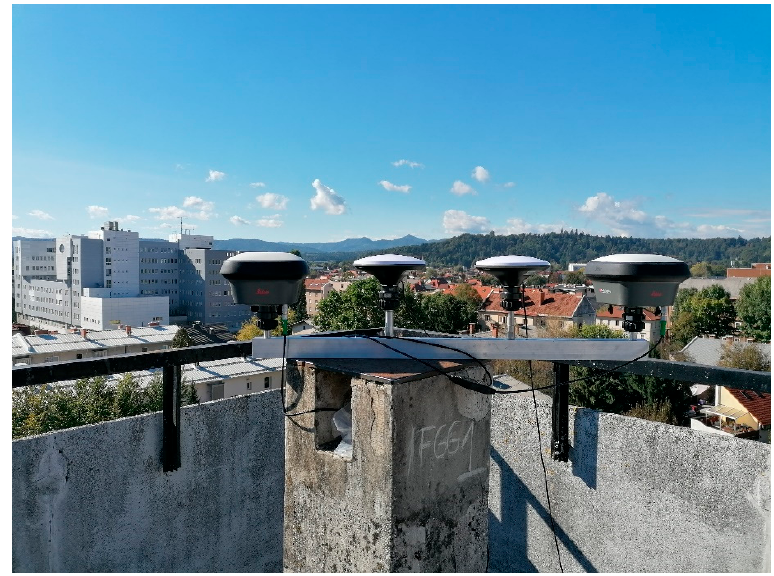
Figure 4. Geodetic and low-cost calibrated antennas with the four-point metal arm.